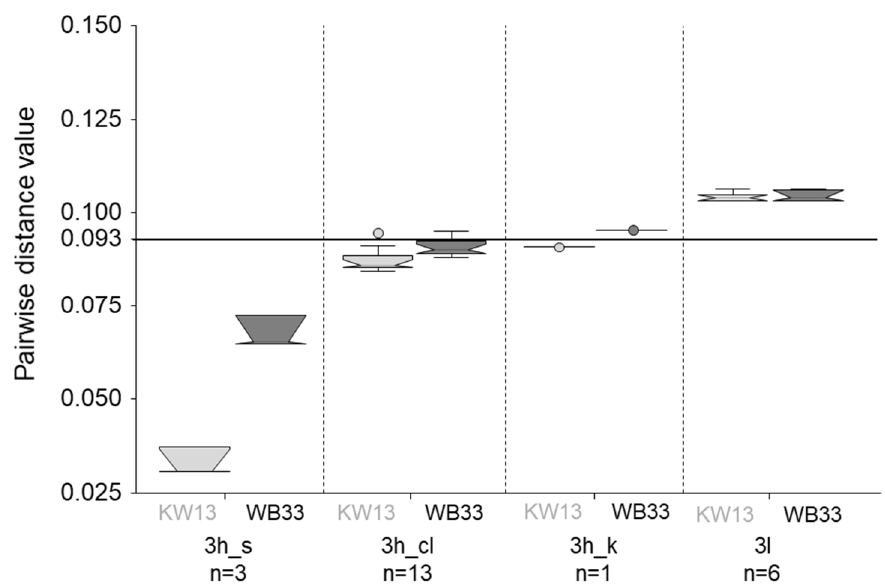
Figure 5. Boxplot visualization of the pairwise distance values of comparing KW13 (light grey) and WB33 (dark grey) full genomes to all full-length reference sequences of subtypes 3h and 3l. Separate distances were calculated for the three clusters within 3h that relate to the classic 3h genomes (3h_cl) and the formerly proposed subtypes 3s(p) (3h_s) and 3k(p) (3h_k) (Figure 4). The number of available references for each subtype/cluster are indicated below the names. The subtype demarcation cut-off of 0.093 is indicated by a horizontal line. The whiskers extend to 1.5x interquartile range (IQR) from the box edge. Outliers are marked by circles. The notches are constructed using the formula: Median +/ − 1.57 × (IQR)/ √ n.